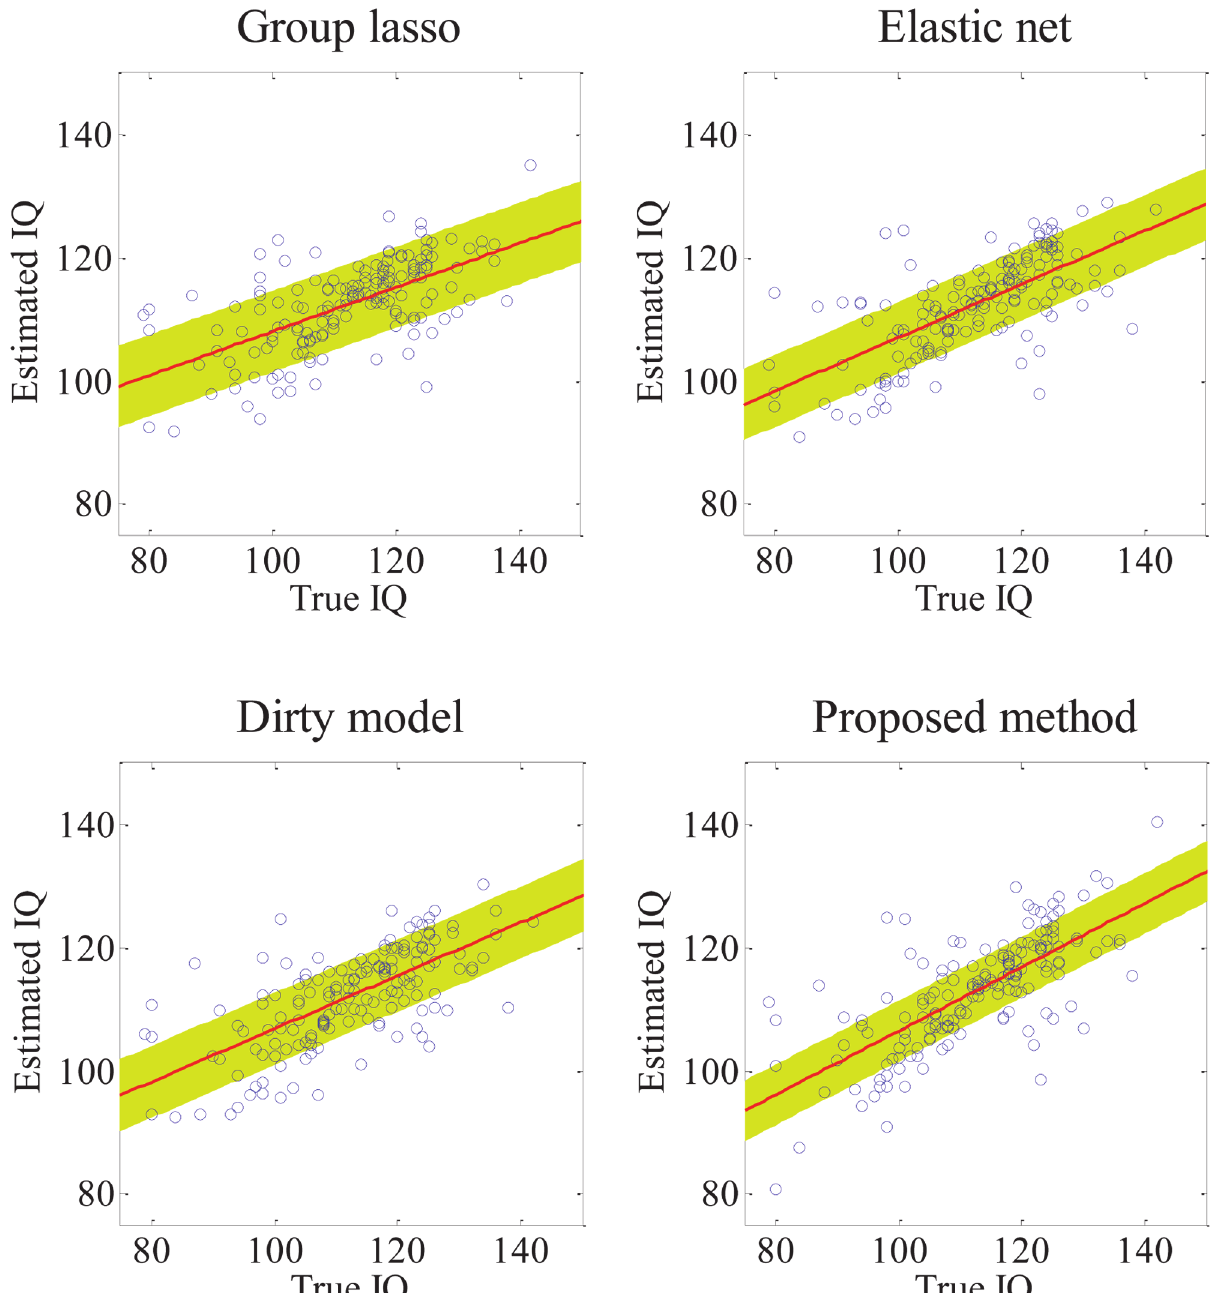
Fig 4. Scatter plots of the true IQ vs. the estimated IQ by multi-kernel SVR. Scatter plots of the true IQ vs. the estimated IQ by the four competing methods with multi-kernel SVR, along with the standard deviation of the distance for each point to the fitted